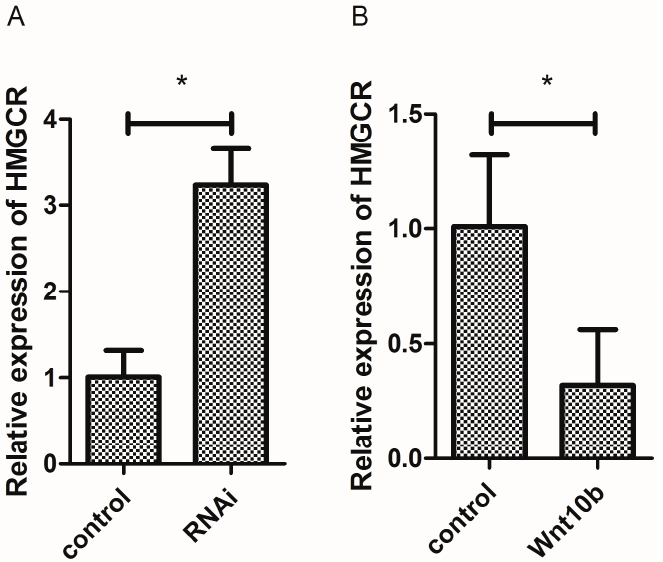
Figure 9. E ff ect of Wnt10b gene interference and overexpression on the mRNA expression of HMG-CoA reductase (HMGCR) in the muscle of zebrafish. ( A ) E ff ect of Wnt10b gene interference on the mRNA expression of HMGCR; ( B ) E ff ect of Wnt10b gene overexpression on the mRNA expression of HMGCR. Values are expressed as means ± s.e.m. ( n = 4). Statistically significant di ff erences are denoted by an asterisk (* p < 0.05).